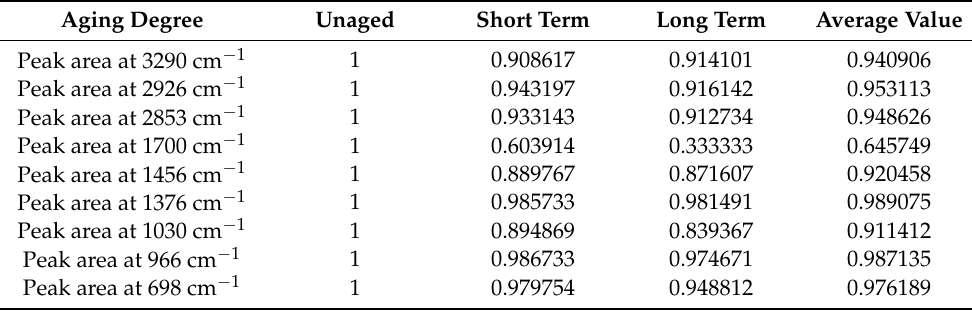
Table 12. Grey correlation degree between W initial and different peak areas